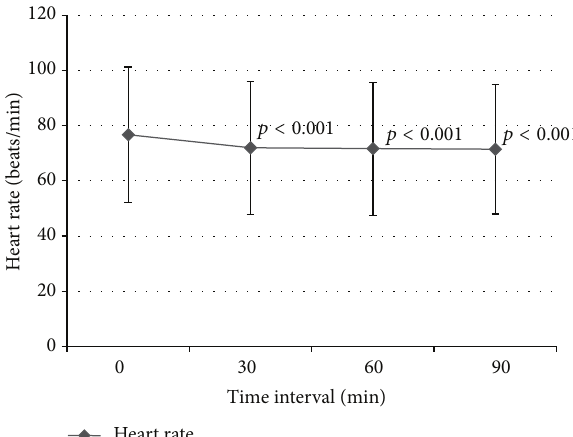
Figure 2: Heart rate over time. Significance value pairwise compar- ison for heart rate (paired 𝑡 -test): 𝑝 < 0.001 for 0 min versus 30 min, 𝑝 < 0.001 for 0min versus 60 min, and 𝑝 < 0.001 for 0min versus 90